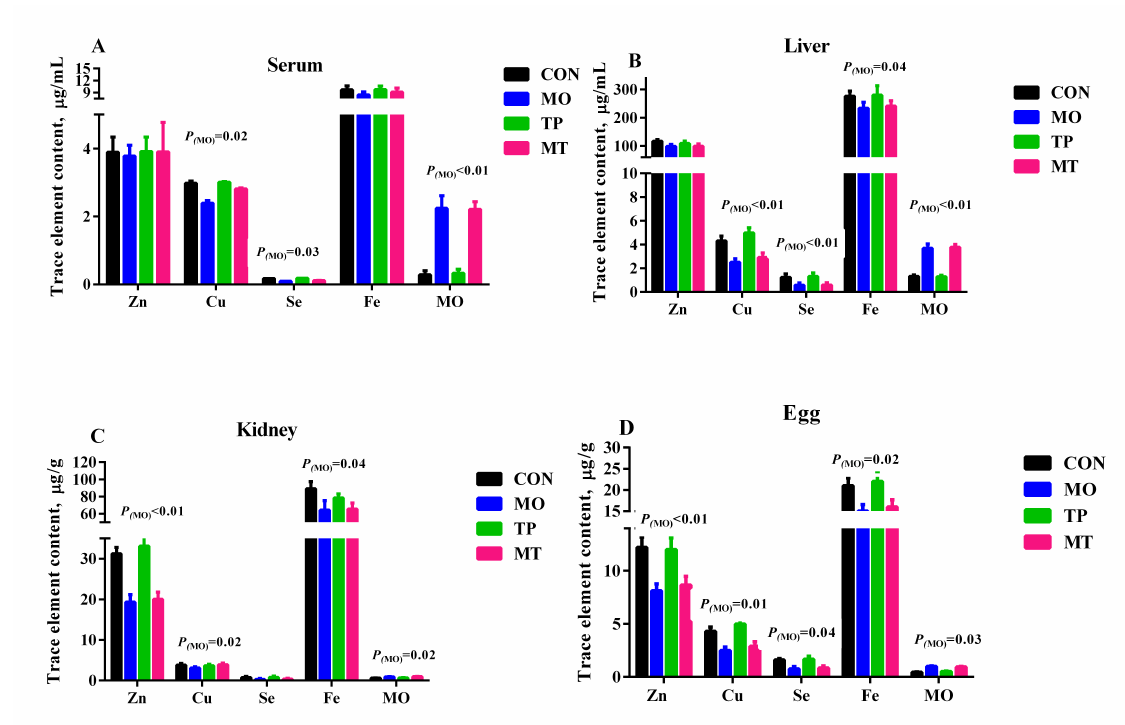
Figure 1. E ff ect of molybdenum and tea polyphenols on the trace element content in serum and tissues. ( A ) Trace element content in serum; ( B ) Trace element content in liver, ( C ) Trace element content in kidney; ( D ) Trace element content in egg (dry matter basis).